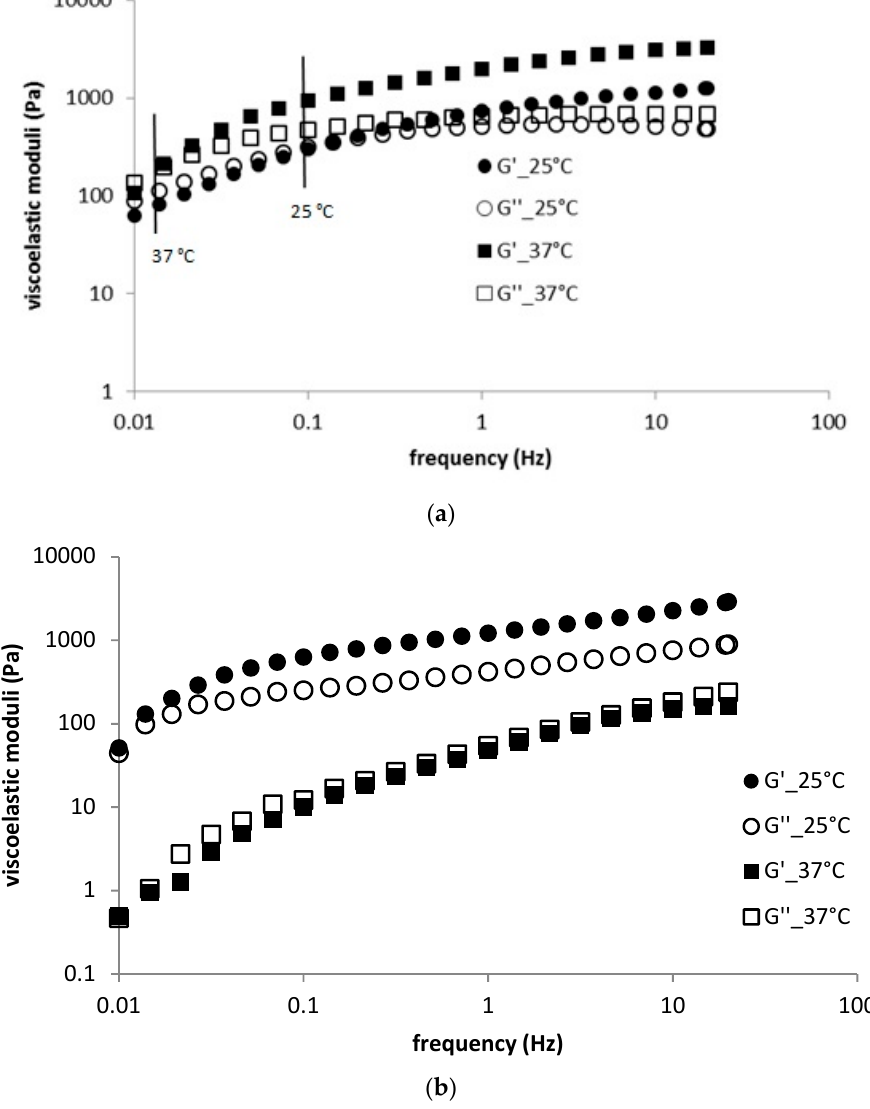
Figure 3. (a) Frequency sweep for H1 sample—temperature dependence; (b) frequency sweep for H4 Figure 3. ( a ) Frequency sweep for H1 sample—temperature dependence; ( b ) frequency sweep